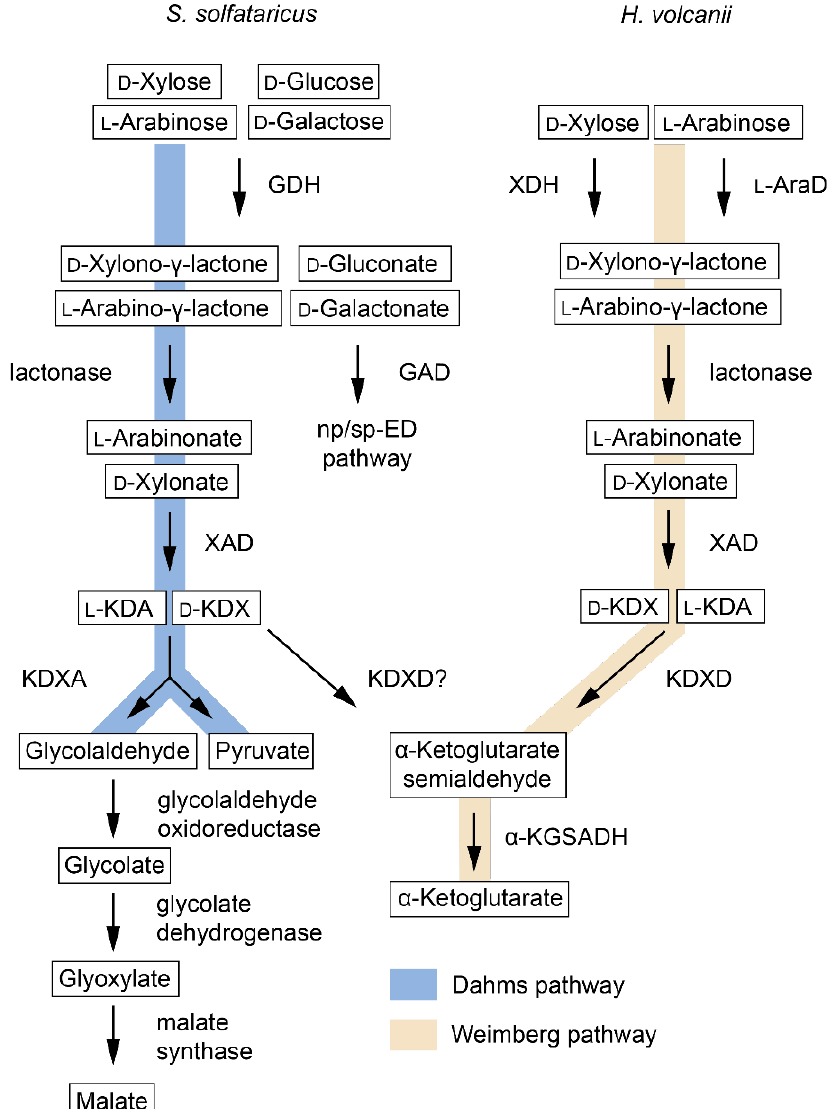
Figure 2. Overview of the Weimberg (brown) and Dahms (blue) pathways and promiscuous pathways for D-xylose and L-arabinose in S. solfataricus and H. volcanii . GDH: Glucose dehydrogenase, XDH: D-xylose dehydrogenase, L-AraDH: L-arabinose dehydrogenase, GAD: Gluconate dehydratase, XAD: Xylonate dehydratase, D-KDX: 2-Keto-3-deoxy-D-xylonate,